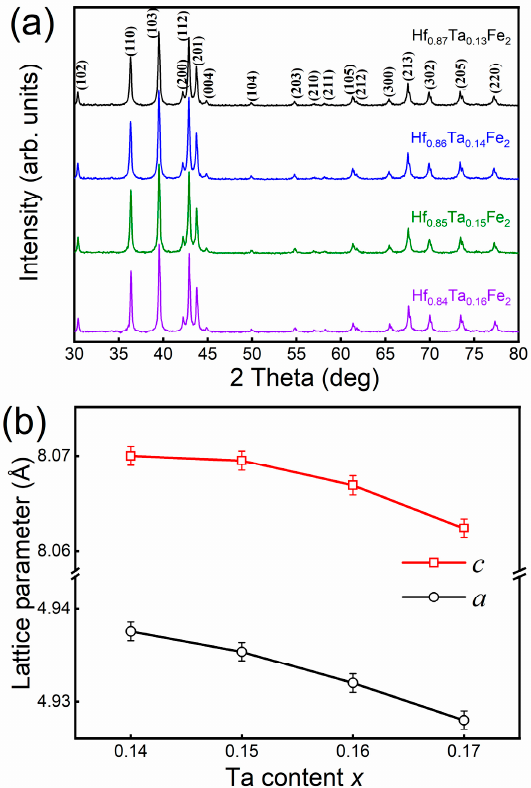
Figure 1. ( a ) Powder X-ray diffraction patterns for the Hf 1 − x Ta x Fe 2 ( x = 0.13, 0.14, 0.15, 0.16) alloys; ( b ) Compositional dependence of lattice parameters.